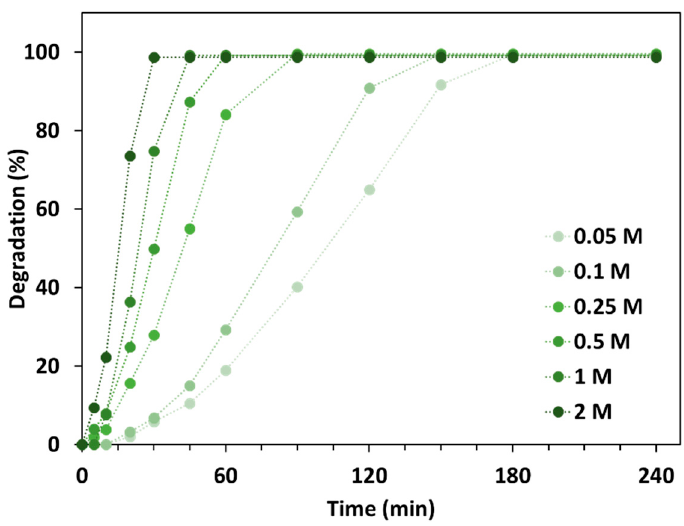
Figure 5. Degradation efficiency using different H 2 O 2 concentrations. Reaction conditions: [catechol- HCP-Fe] = 1 g/L, [MB] = 100 ppm, pH = 6 (neutral pH), room temperature (27 ◦ C).